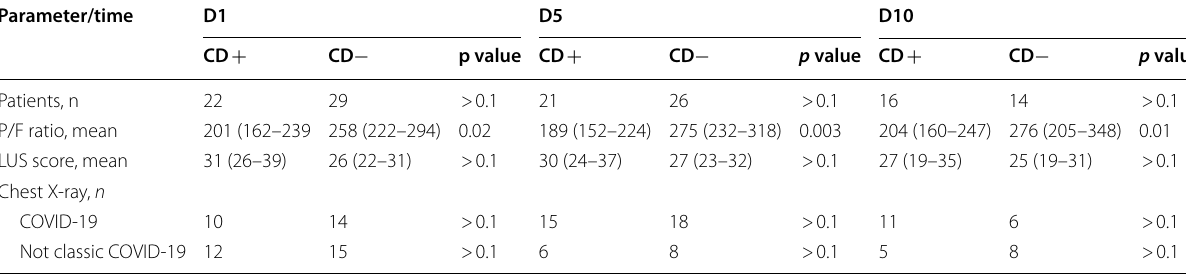
Data are shown as the number of patients ( n ) or mean and 95% confidence interval (between parentheses) CD cardiac dysfunction, LUS lung ultrasound, CD +